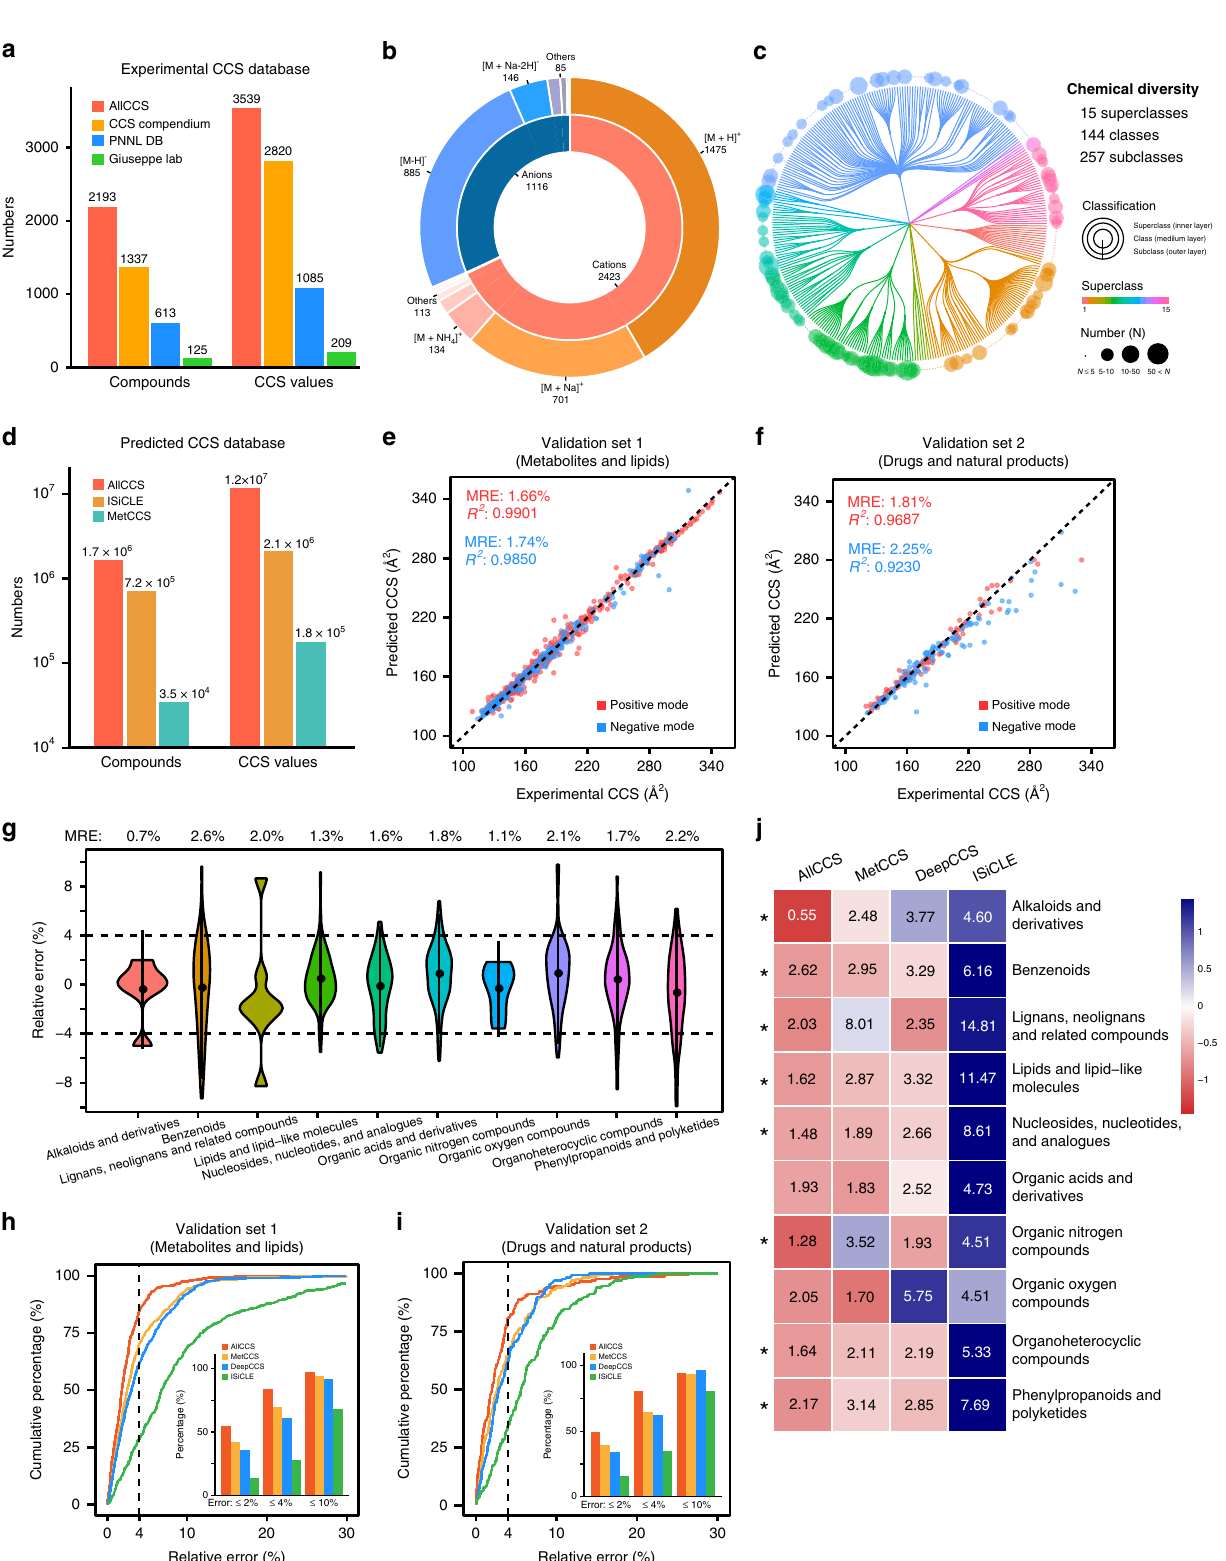
learning-based prediction model using the rest compounds as usual (Fig. 3a). Then, CCS values in validation sets were predicted and divided into two types: the excluded super class (i.e., lipids and lipid-like molecules) and other super classes, and further compared with the results in Fig. 2g. Taken lipids and lipid-like molecules as examples, the predicted CCS values in validation set